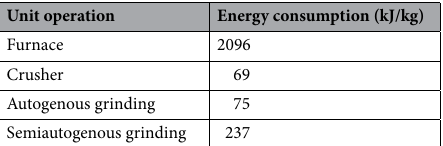
Table 3. Energy consumption for different unit operations.